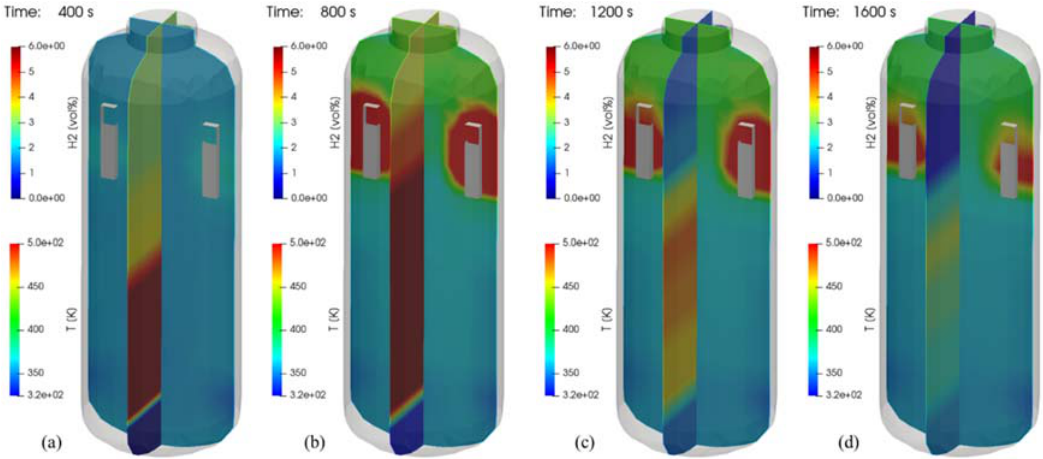
Figure 25. Visualization of hydrogen and temperature distributions for the SP1 test (temperature contours on a plane crossing the PARs). ( a ) at 400 s; ( b ) at 800 s; ( c ) at 1200 s; ( d ) at 1600 s.